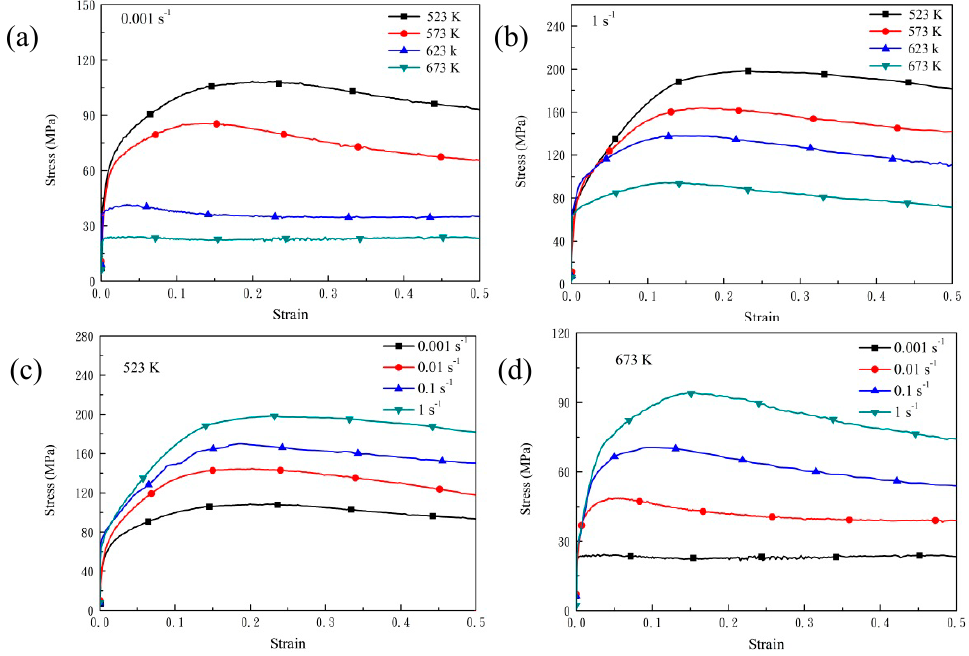
− 1 ; ( b ) 1 s − 1 ; ( c ) 523 K;